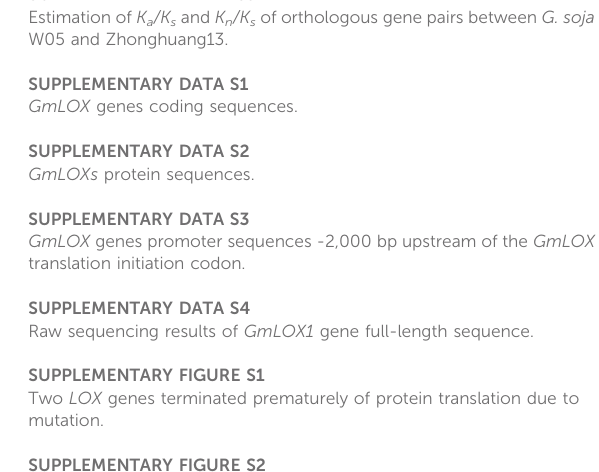
SUPPLEMENTARY TABLE S1 Primers for 12 GmLOX genes and three internal reference genes. SUPPLEMENTARY TABLE S2 Homologous gene pairs between Zhonghuang 13 and Williams 82. SUPPLEMENTARY TABLE S3 Gene names corresponding to sequence IDs in four outgroup species. SUPPLEMENTARY TABLE S4 The summary of functional cis elements number of each GmLOX gene.